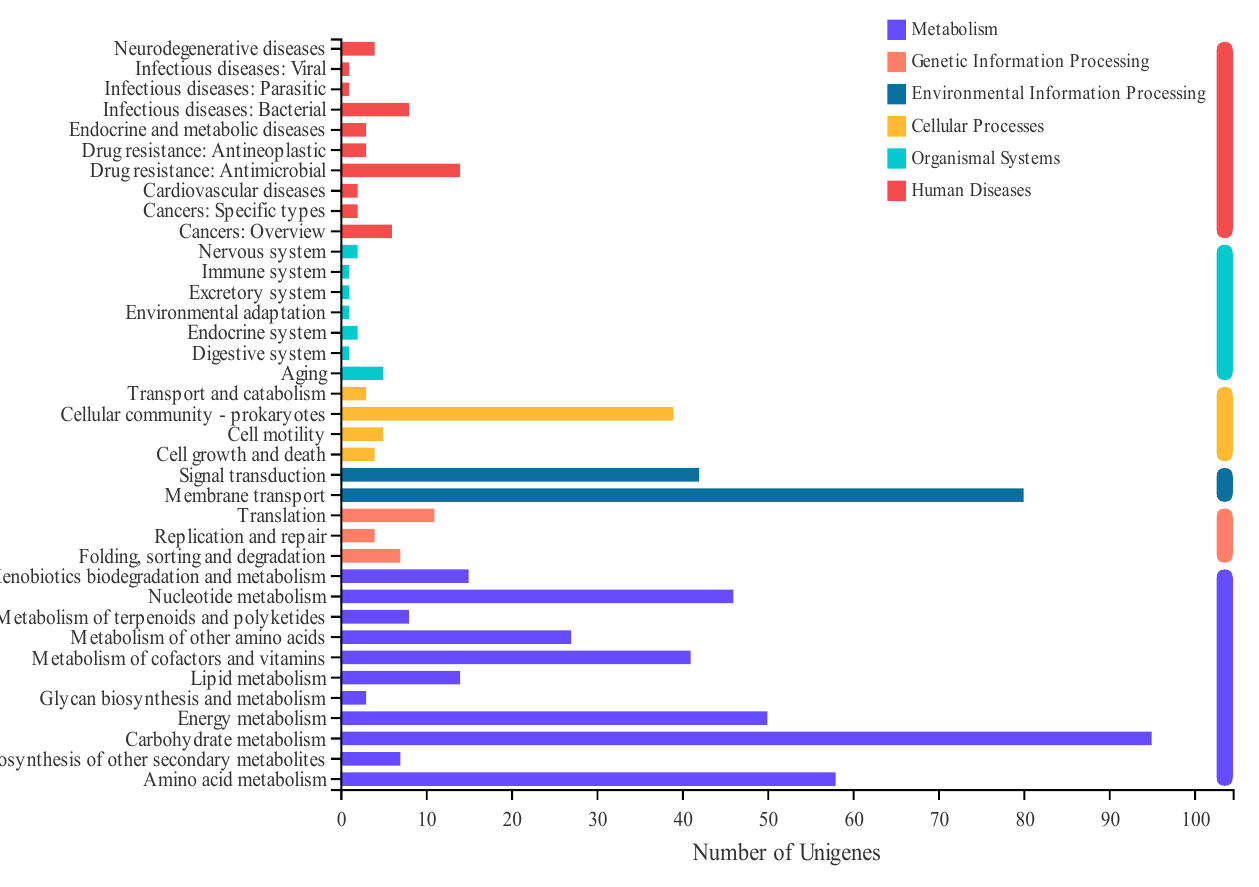
Table 2. KEGG pathway functional annotation of differentially expressed genes.